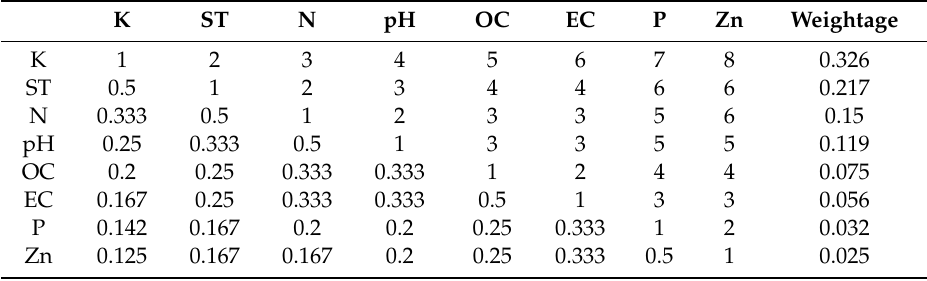
Table 7. Pair wise comparison matrix and eigenvector of criteria in AHP for potato crop ( n = 8).